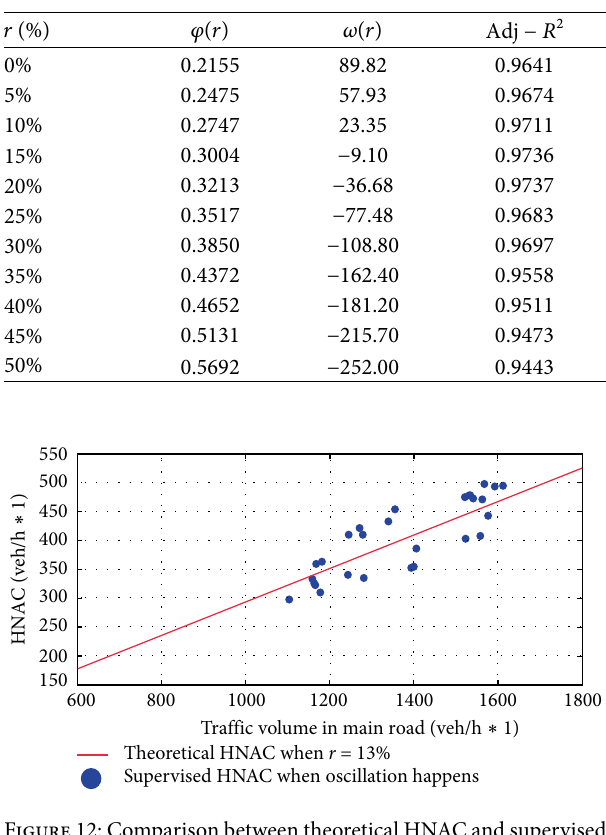
Figure 12: Comparison between theoretical HNAC and supervised